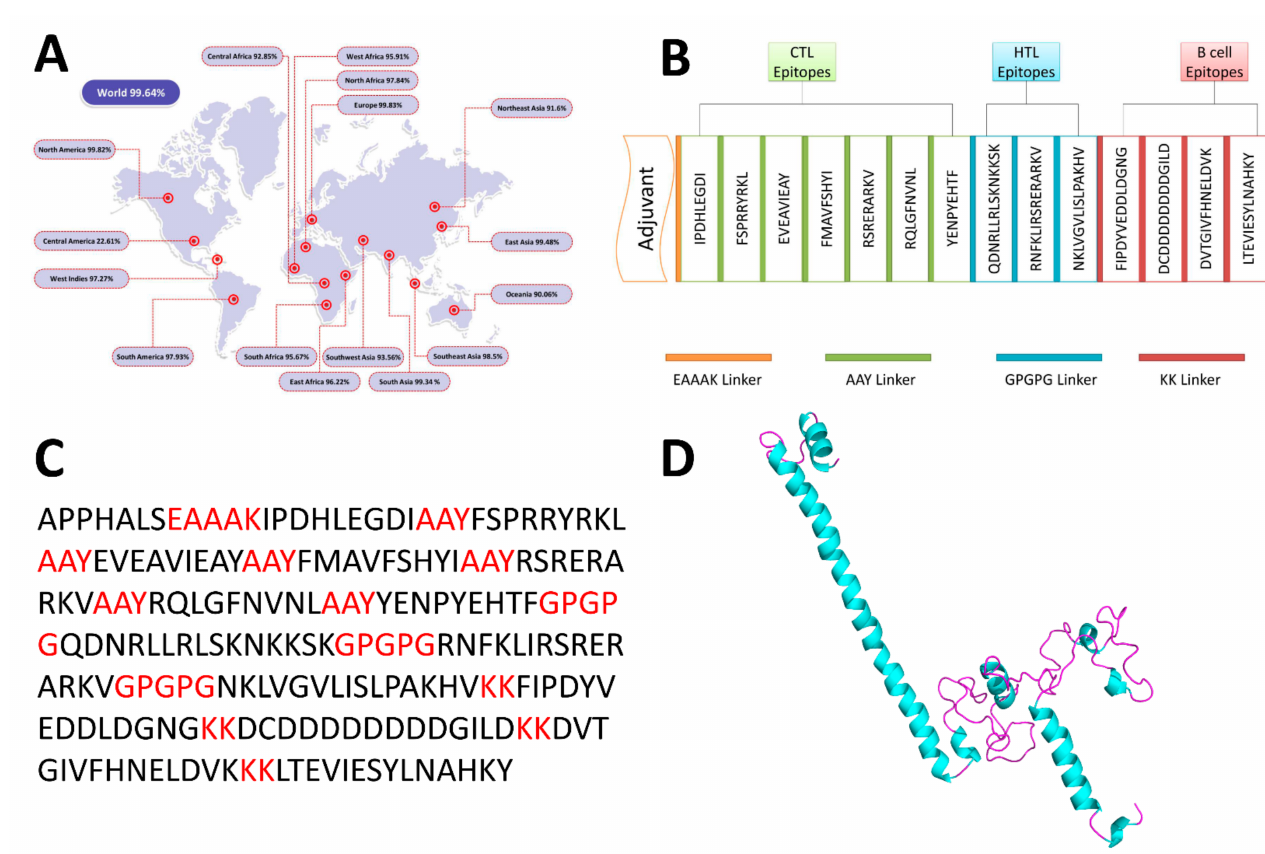
Figure 1. Different vaccine design analyses performed in this study. ( A ) Worldwide population coverage of MEV epitopes. ( B ) Schematic representation of the final vaccine construct components. ( C ) Primary sequence of the MEV, where a red color represents linkers and black color represents adjuvant and epitopes. ( D ) 3D model of the